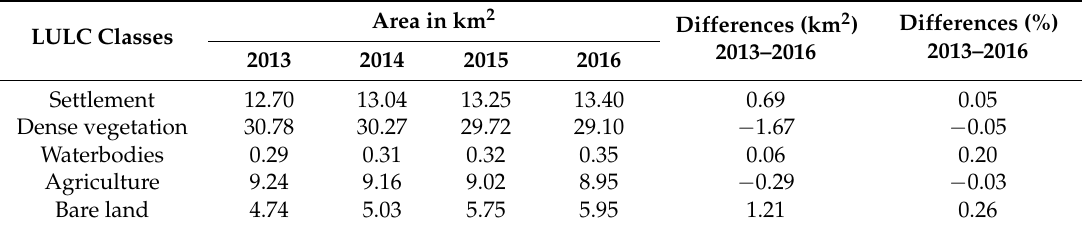
LULC Classes Table 3. Comparison of the land-use and land cover (LULC) types during 2013–2016.